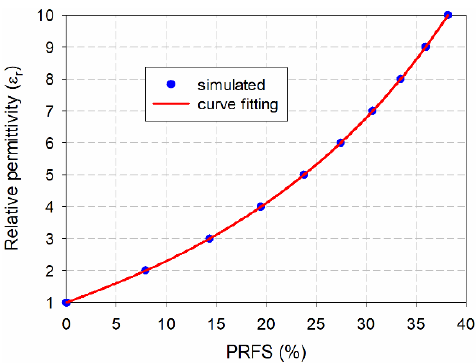
Figure 7. Simulated and curve-fitted relative permittivity of the material under test (MUT) vs. percent relative frequency shift ( PRFS ).